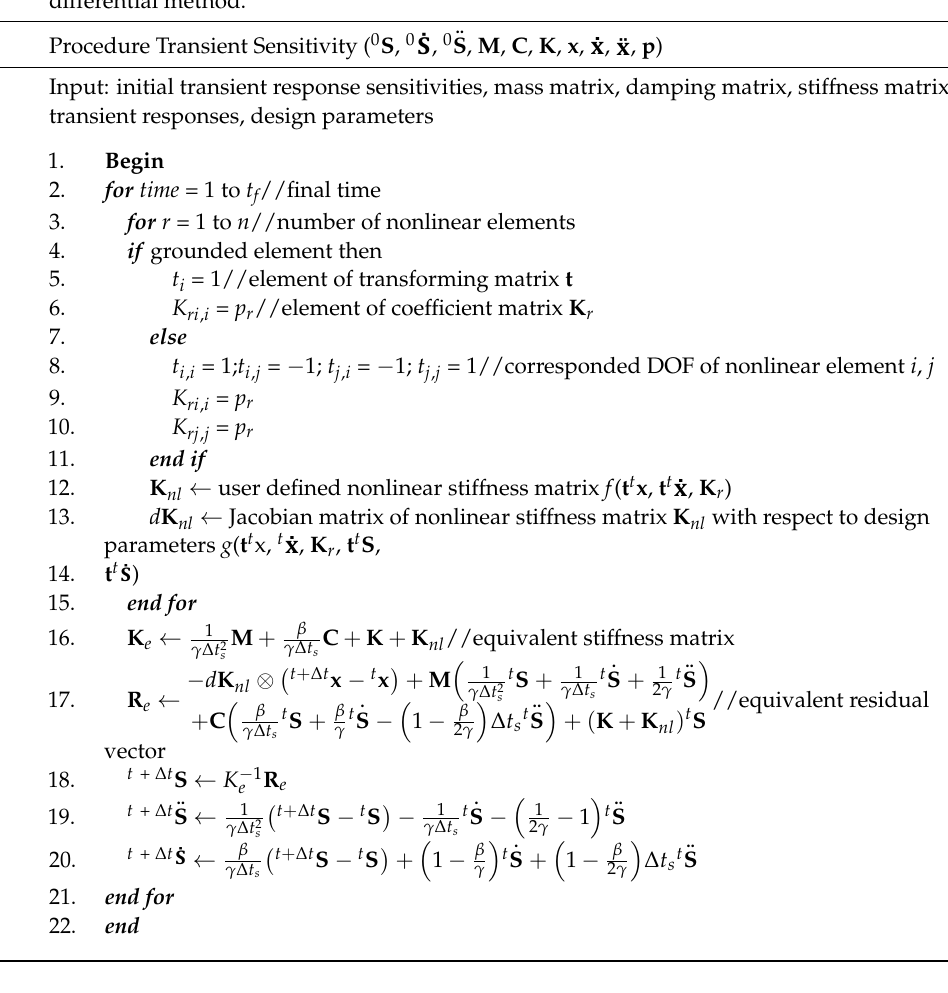
Algorithm 2. Pseudo-code for nonlinear transient response sensitivity analysis using direct differential method. Procedure Transient Sensitivity ( 0 S , 0